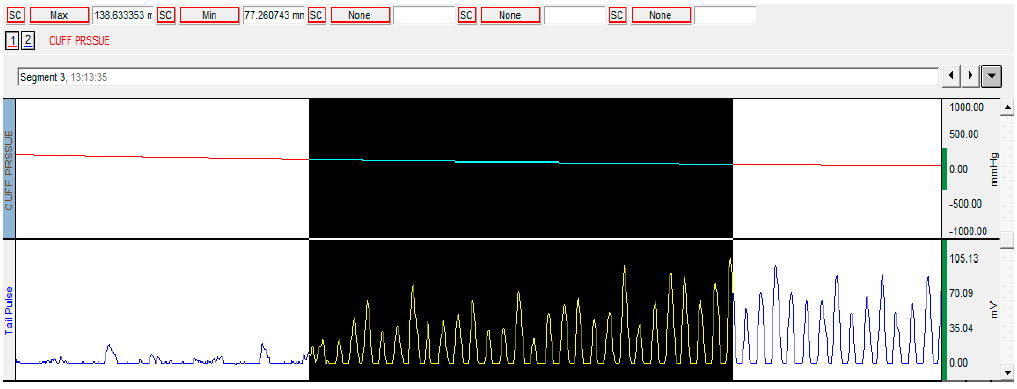
Figure 12. Blood pressure measurement method.